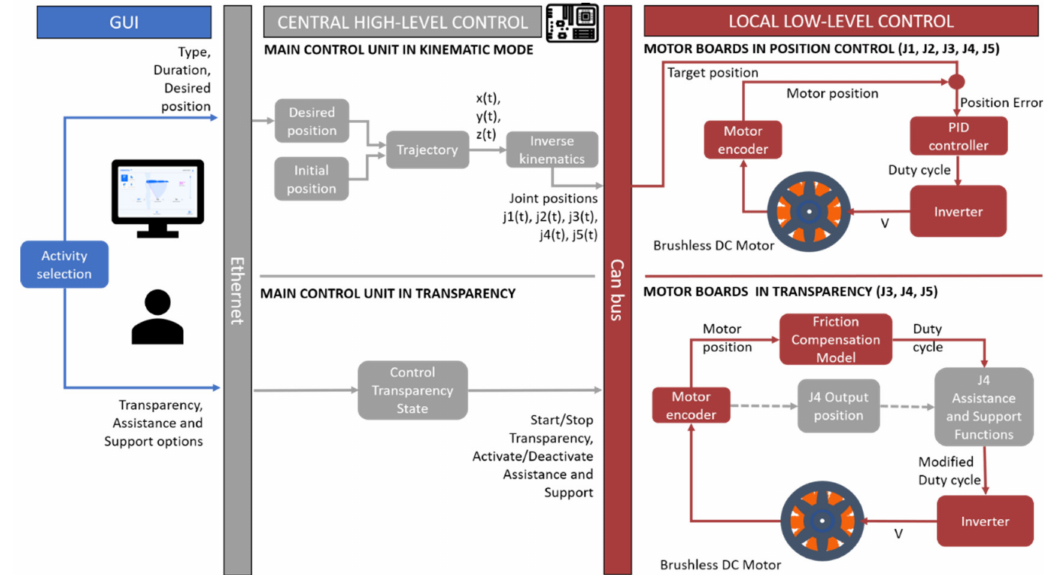
Figure 5. Schematics of the software architecture including the GUI, the main control unit and the local low-level control.